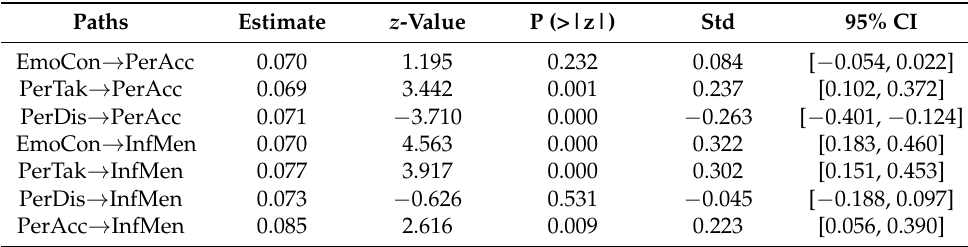
Table A2. Multiple mediation analyses for direct effects from dimensions of empathy to personal accomplishment through the inference of mental states.